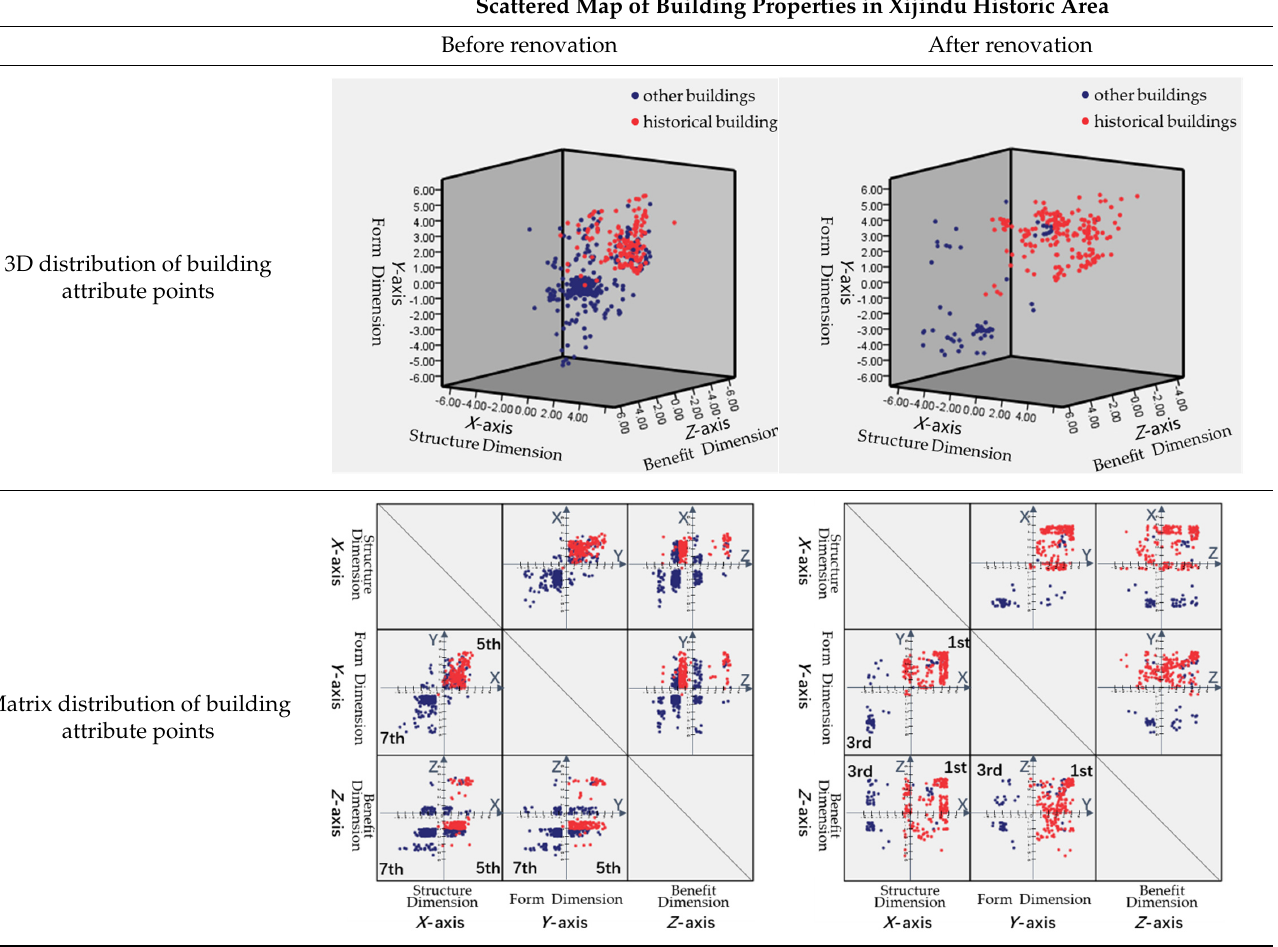
Table 3. Three-dimensional coordinate space expression of scattered points of building attributes in Xijindu area. Table 3. Three ‐ dimensional coordinate space expression of scattered points of building attributes in Table 3. Three ‐ dimensional coordinate space expression of scattered points of building attributes in Table 3. Three ‐ dimensional coordinate space expression of scattered points of building attributes in Table 3. Three ‐ dimensional coordinate space expression of scattered points of building attributes in Xijindu area. Xijindu area. Xijindu area. Xijindu